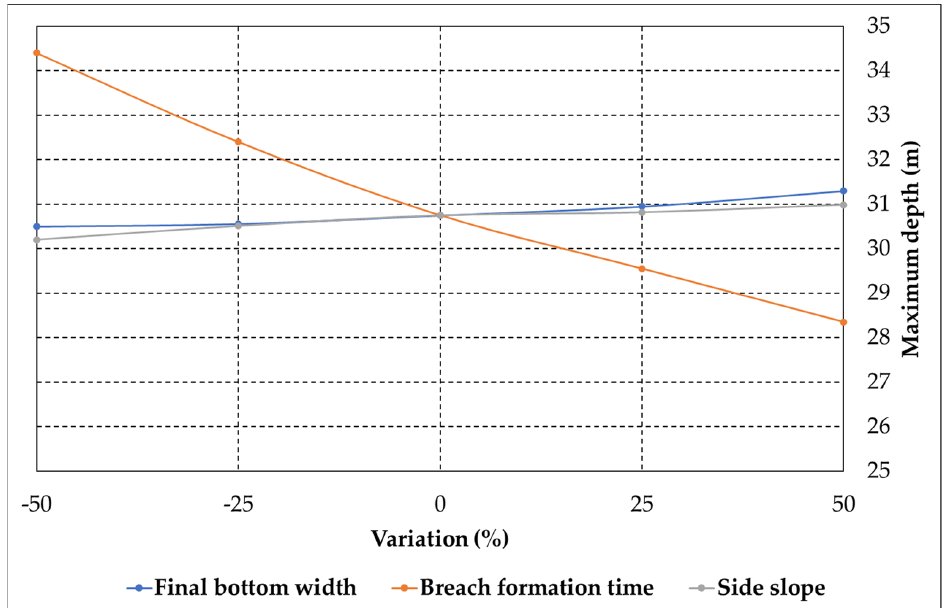
Figure 12. Maximum water depth for varying breach parameters..